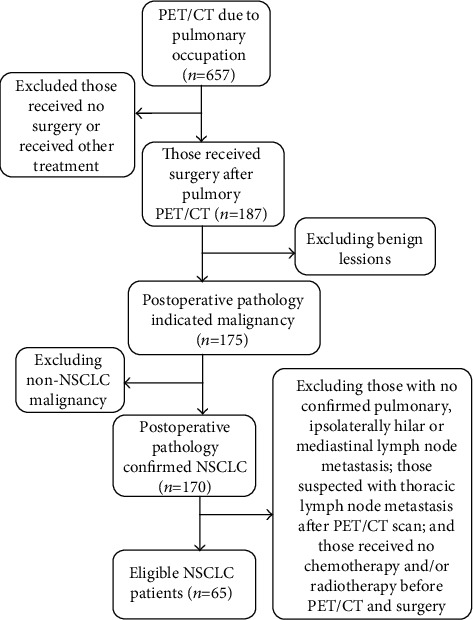
Study flowchart.